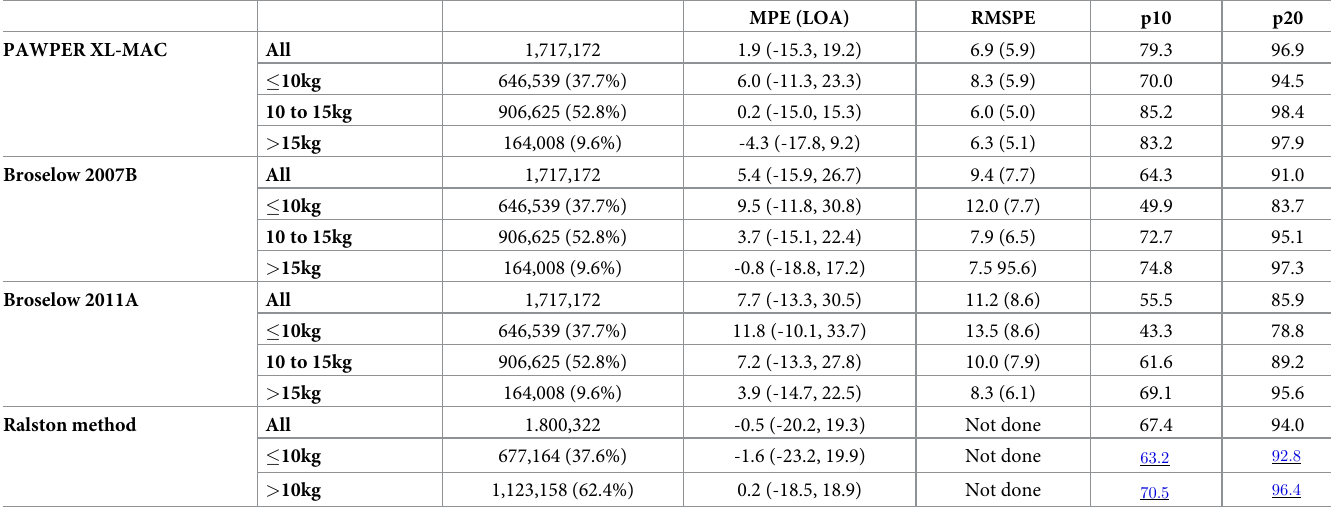
Table 5. Weight estimation performance by subgroups of